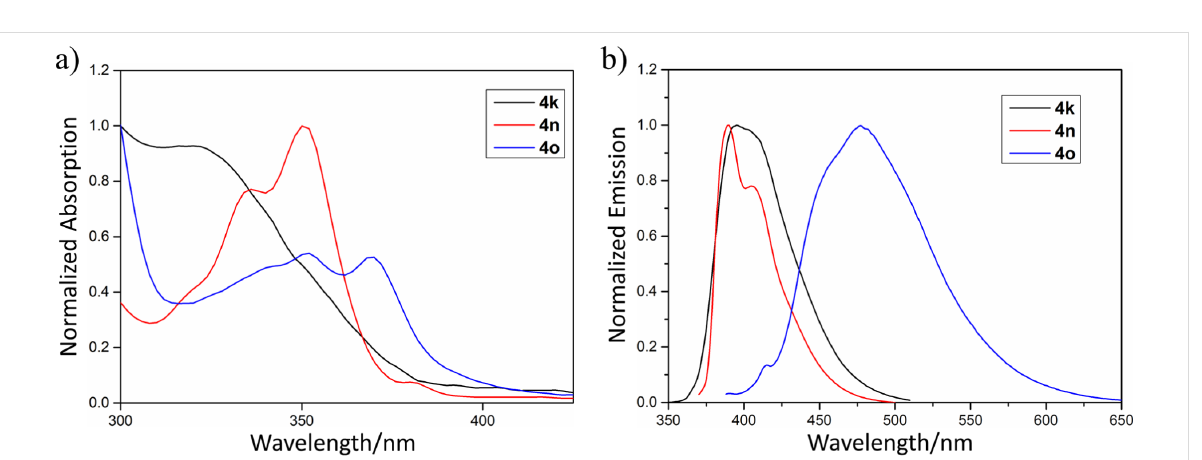
Figure 1: a) UV-visible absorption spectra of 4k , 4n and 4o in toluene (1 × 10 − 5 mol/L). b) Emission spectra of 4k , 4n and 4o in toluene (1 × 10 − 5